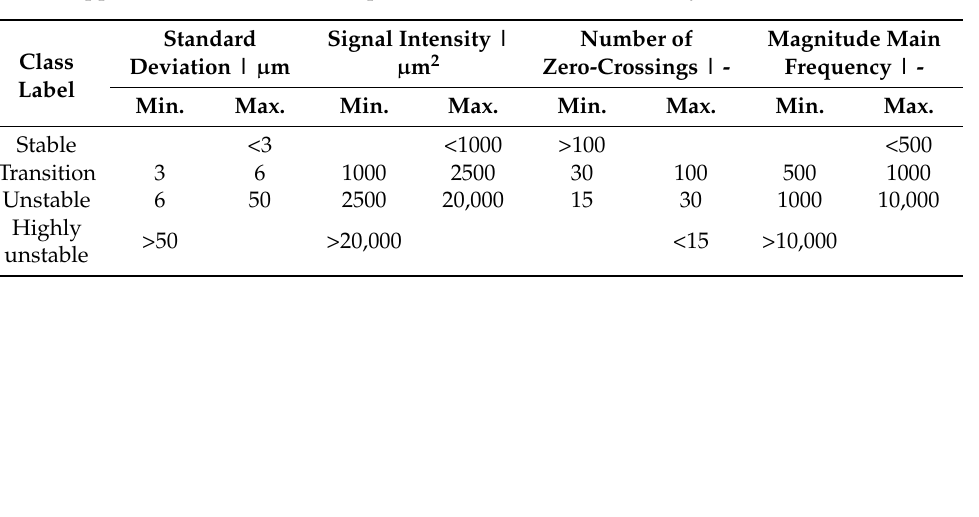
Figure 14. Fast Fourier transform of the real length position of the polymer-polymer interface over time, shifted by the mean, for ( a ) operating point 2 and ( b ) operating point 5.